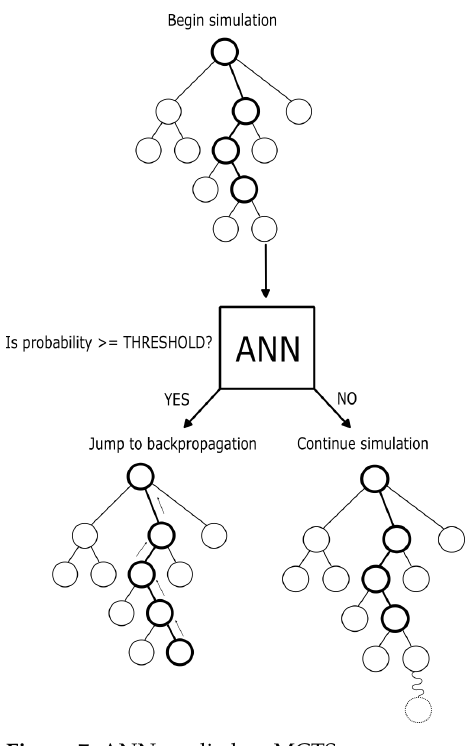
Figure 7. ANN applied on